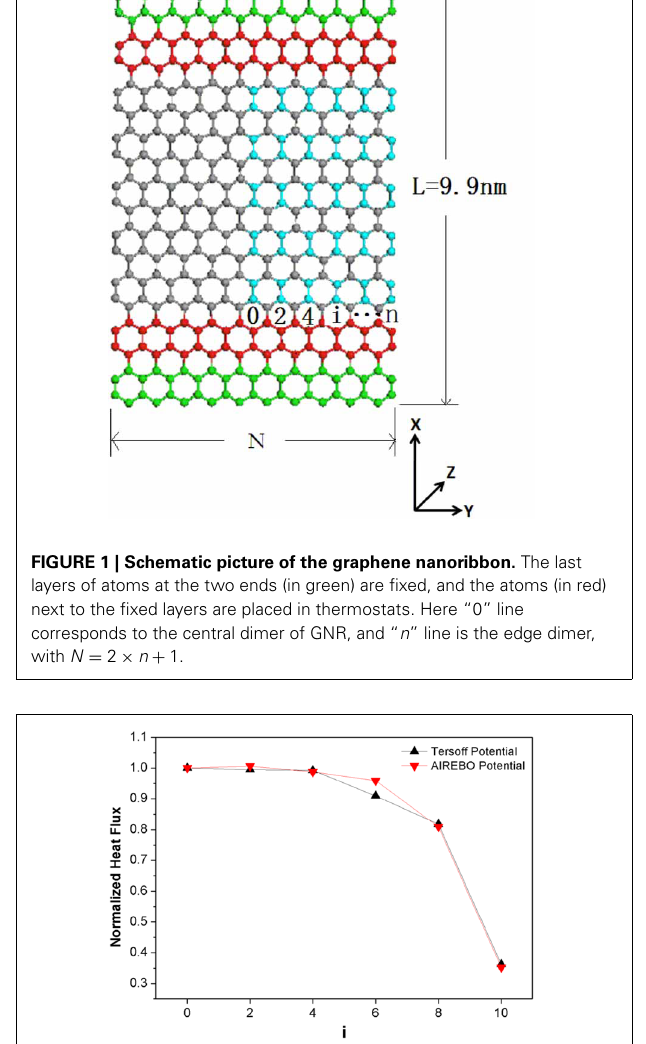
are performed long enough (10 8 time steps, time step is 0.5 fs)